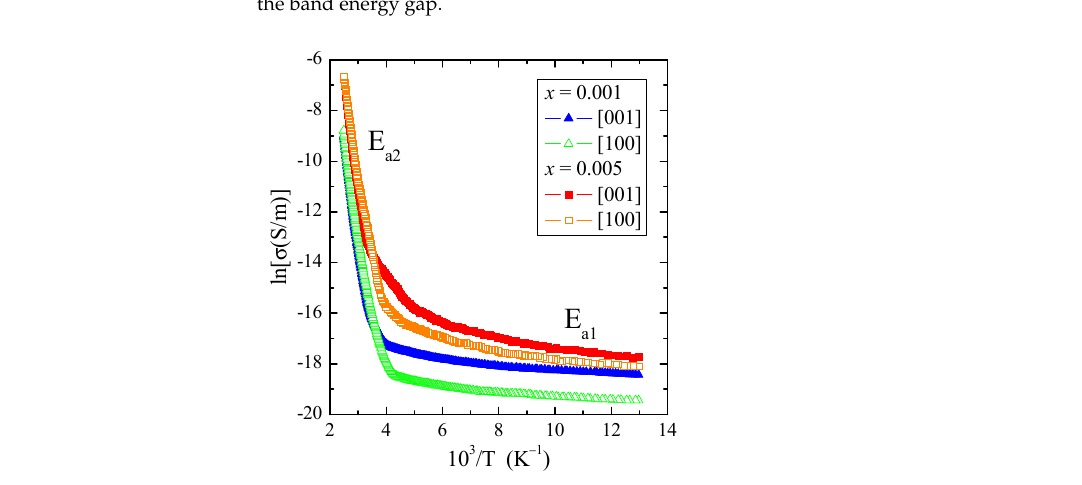
Figure 6. Electrical conductivity (ln σ ) vs. reciprocal temperature 10 3 /T of PNMWO single crystals. E a1 and E a2 are the activation energies in the extrinsic and intrinsic regions,